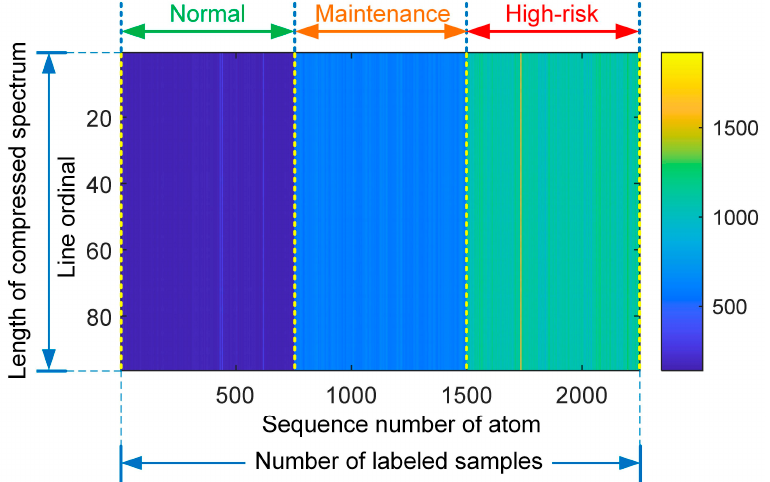
Figure 13. LGPG: dictionary matrix.